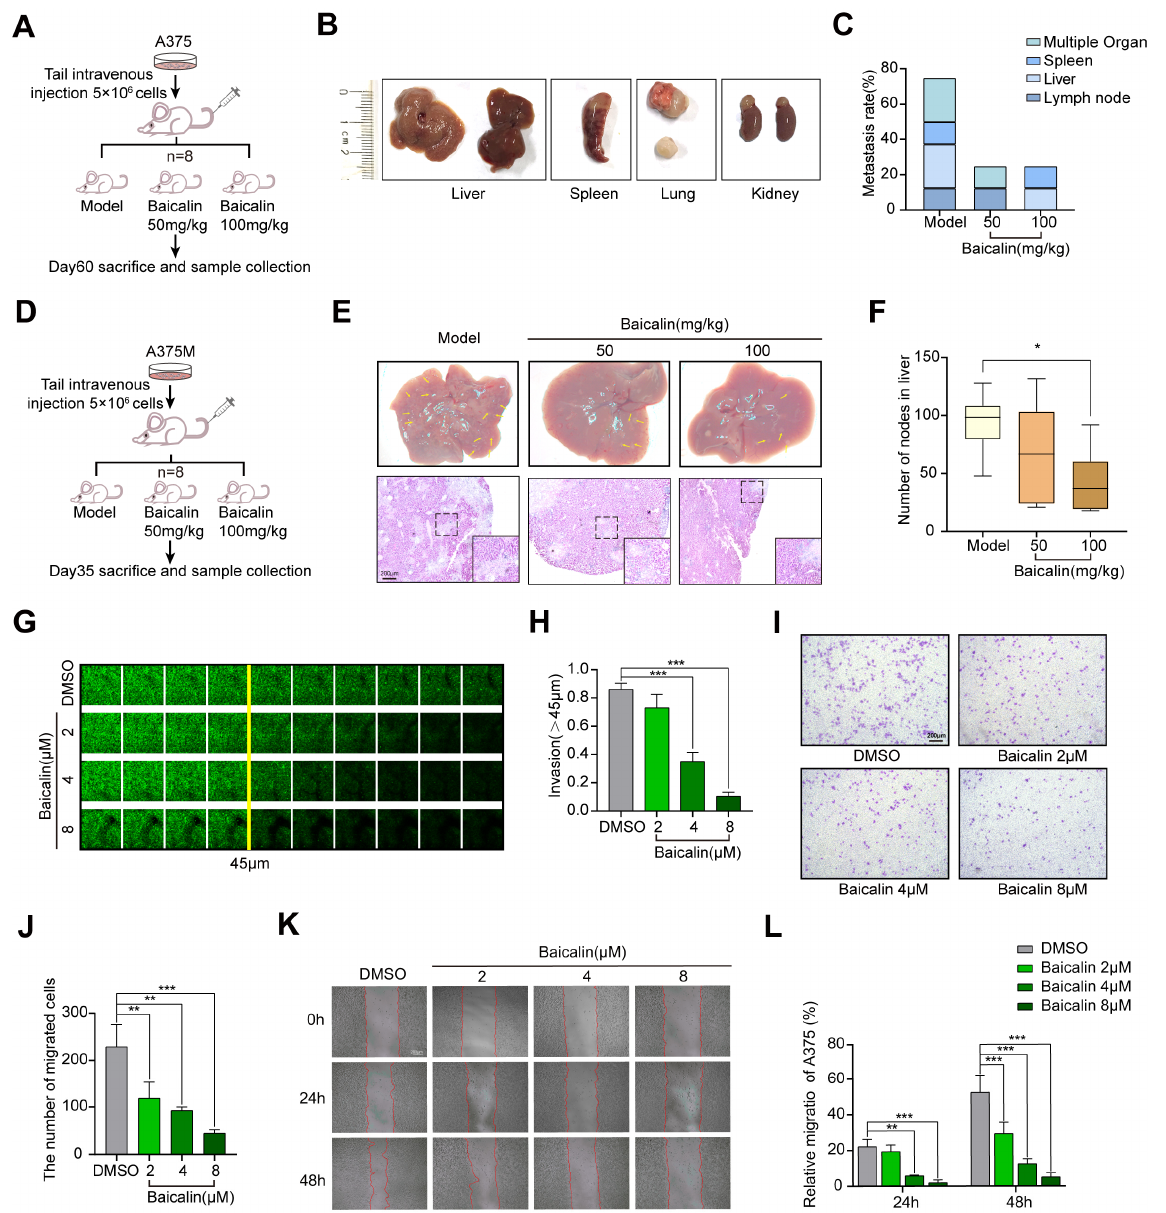
Figure 4. Baicalin inhibits A375 metastasis. ( A ) BALB/c-Nude mice were i.v. engrafted with 5 × 10 6 A375 cells (n = 8, each group). ( B ) Metastatic colonies formed in the liver, spleen, kidney, and lymph node 60 days after A375 melanoma cells injection, with 50 mg/kg, 100 mg/kg Baicalin or saline. ( C ) Metastasis rate of mouse injected A375 cells treated with or without Baicalin. ( D ) BALB/c-Nude mice were i.v. engrafted with 5 × 10 6 A375M cells (n = 8, each group). ( E ) Metastatic colonies formed in the liver at 21 days and mice were sacrificed at day 35 after A375M melanoma cell injection, with 50 mg/kg, 100 mg/kg Baicalin or saline treatment. HE staining patterns showed blue. 40 × . Scale bar, 200 µ m. ( F ) The number of metastatic nodes was counted. ( G , H ) Measurement of A375 cell invasion ability using 3D stroma invasion assay with or without incubating with Baicalin for 24 h. ( I , J ) Measurement of A375 cell migration ability using the trans-well system with or without incubating with Baicalin for 24 h. Views were selected randomly from each sample and migrated cells were counted (three views were randomly selected for each group). 100 × . Scale bar, 200 µ m. ( K , L ) Measurement of A375 and A375 cell migration ability using a wound-healing assay with or without incubating with Baicalin for 24 h. Views were selected randomly from each sample. 100 × . Scale bar, 200 µ m. Data are expressed as means ± SD. * p < 0.05, ** p < 0.01, *** p <